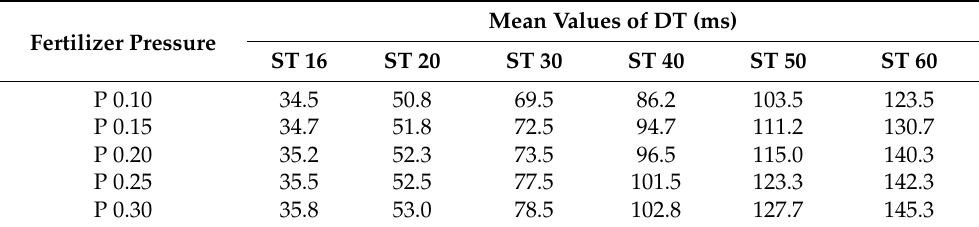
Table 1. Mean values of the duration of applying the liquid starter fertilizer (DT) to every seed at the different time set using the timer in the controller (ST) and